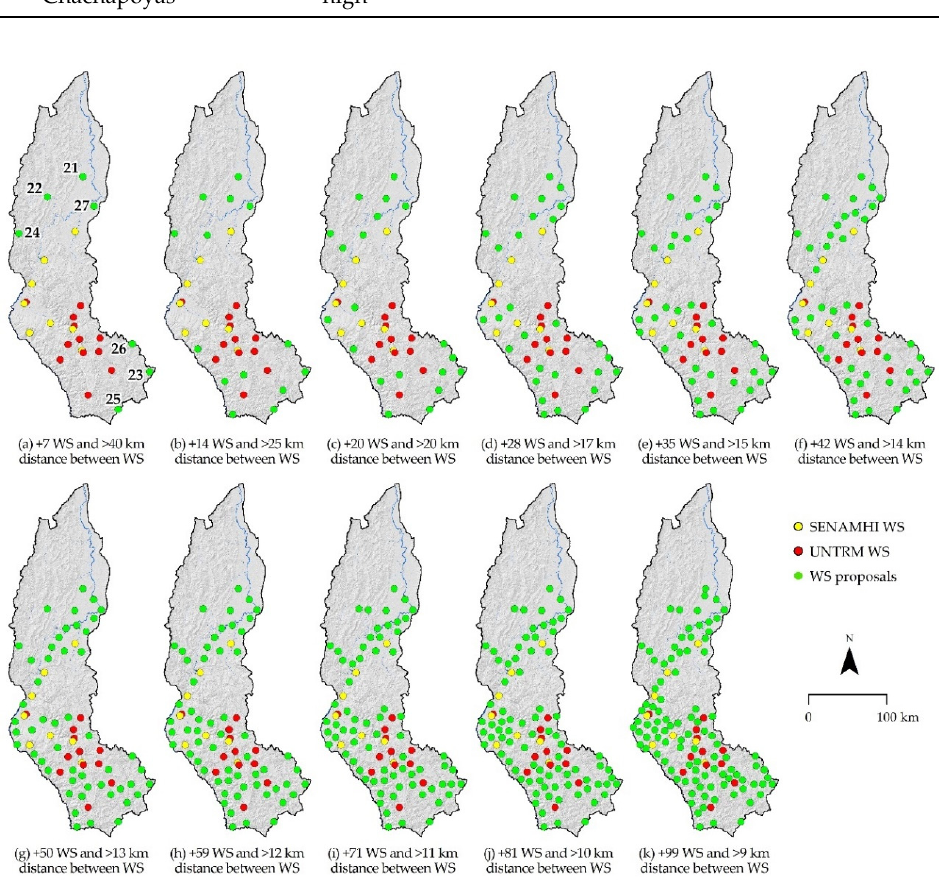
Figure 6. The final suitable weather stations (WS) sites and location of current weather stations (WS) in Amazonas, NW Peru.